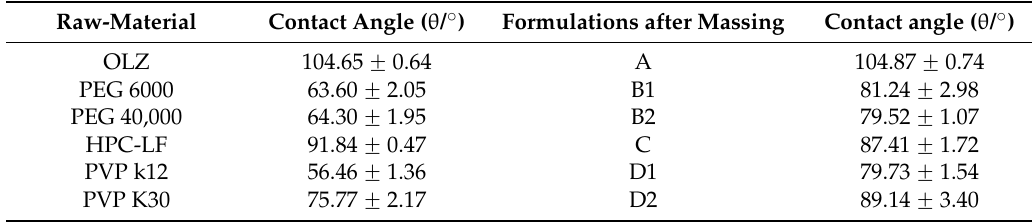
Table 2. Contact angles of the raw materials and different formulations 1 . Raw-Material Contact Angle ( θ / ˝ ) Formulations after